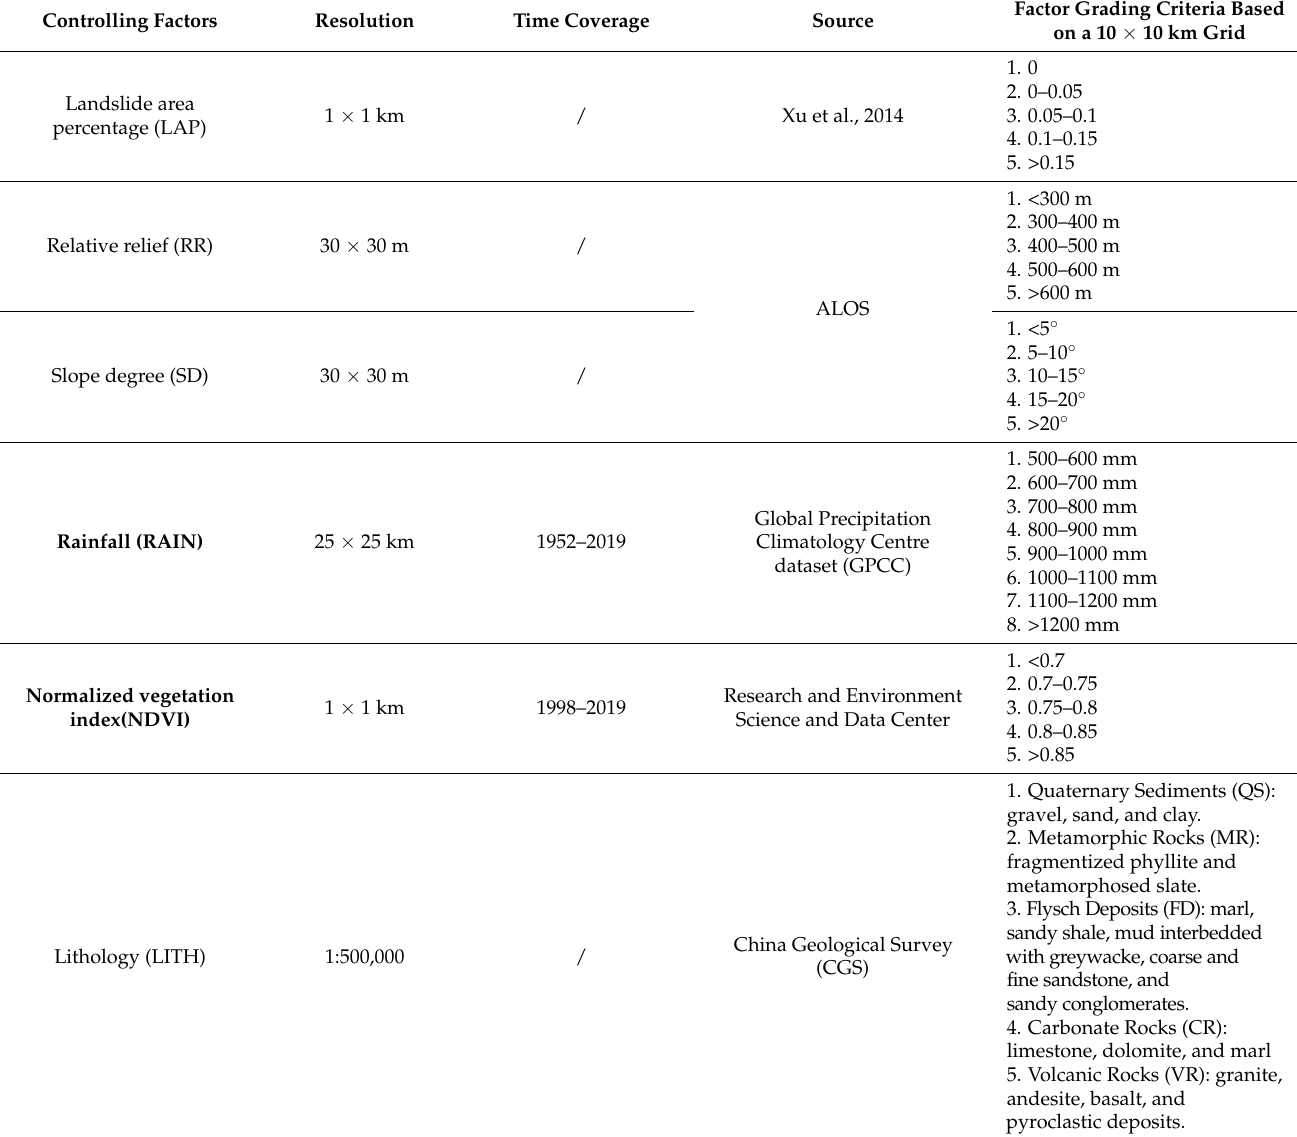
Table 3. Information of controlling